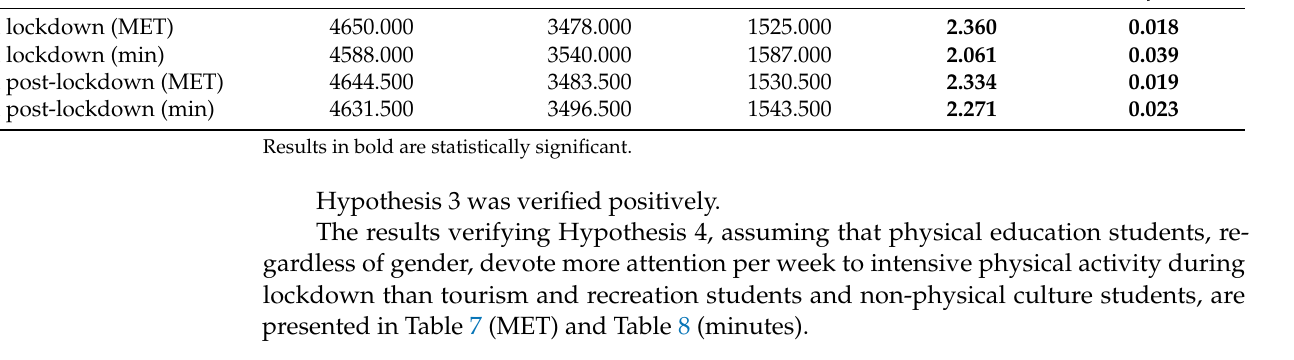
Table 7. Comparison of the high physical activity measured in MET units during the lockdown period. Field of Study